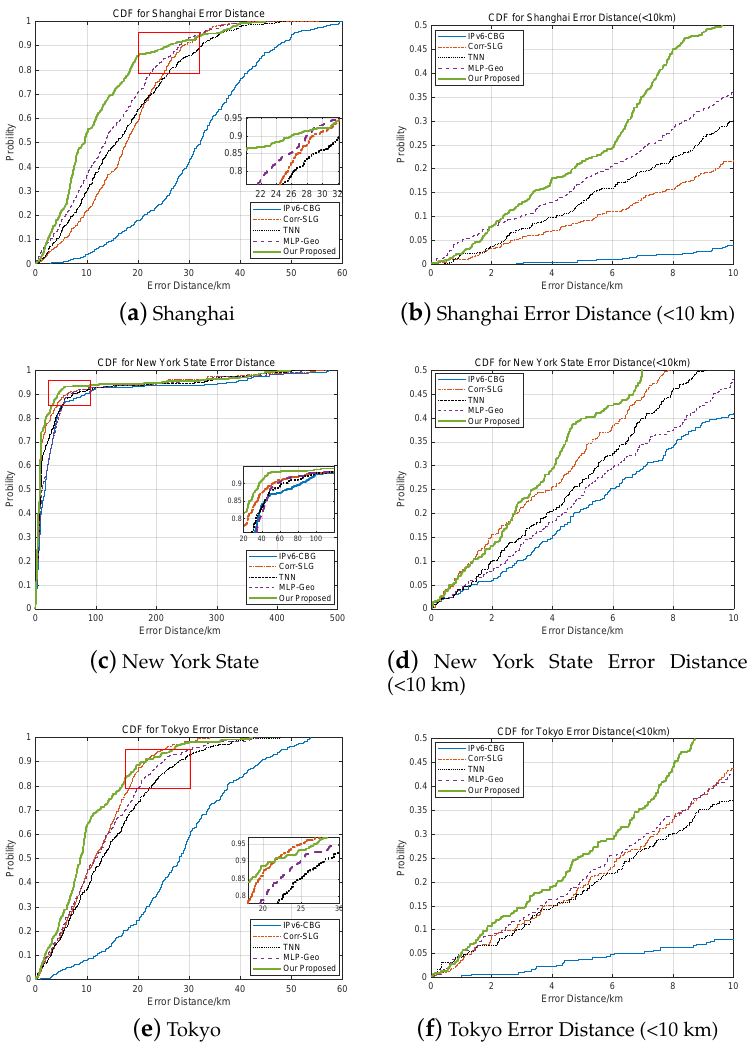
Figure 5. Error distance CDF of the three